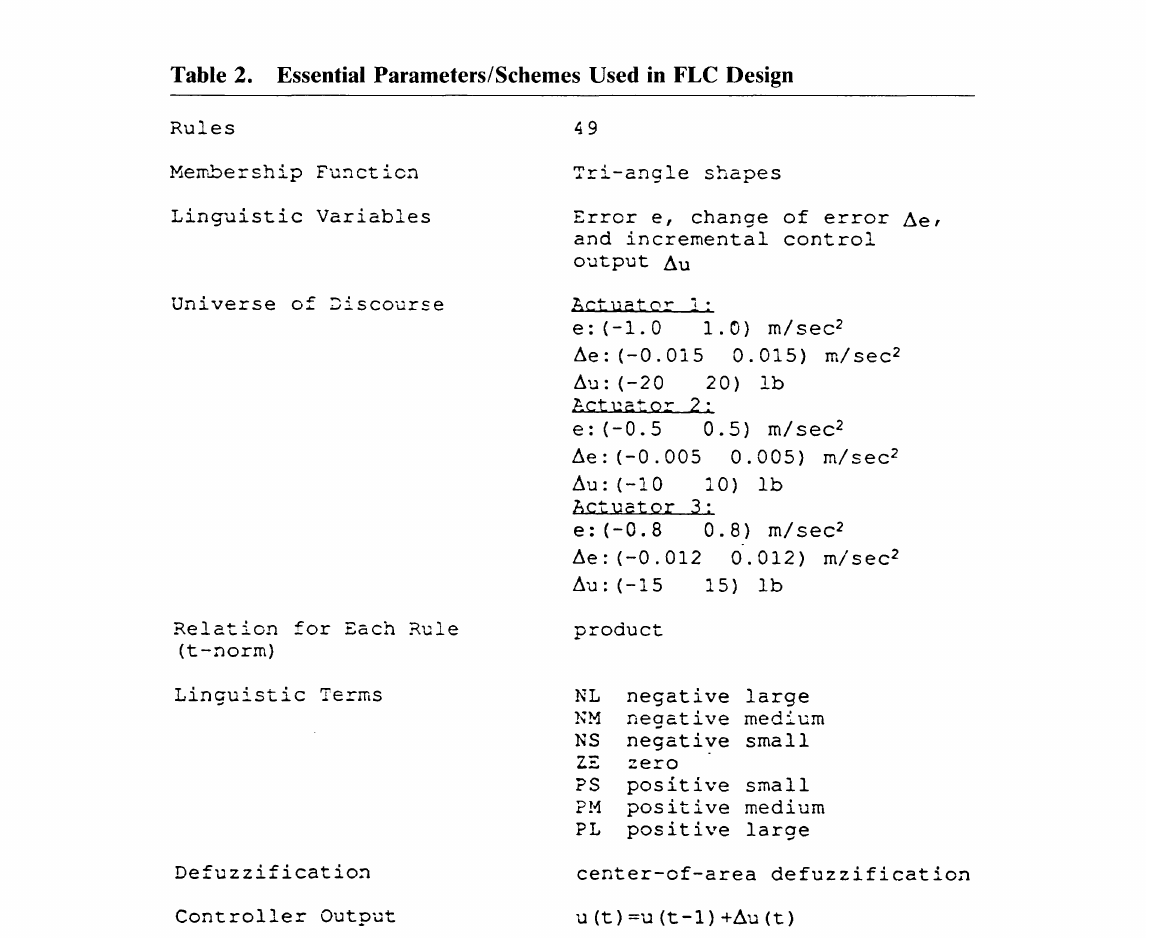
Table 2. Essential Parameters/Schemes Used in FLC